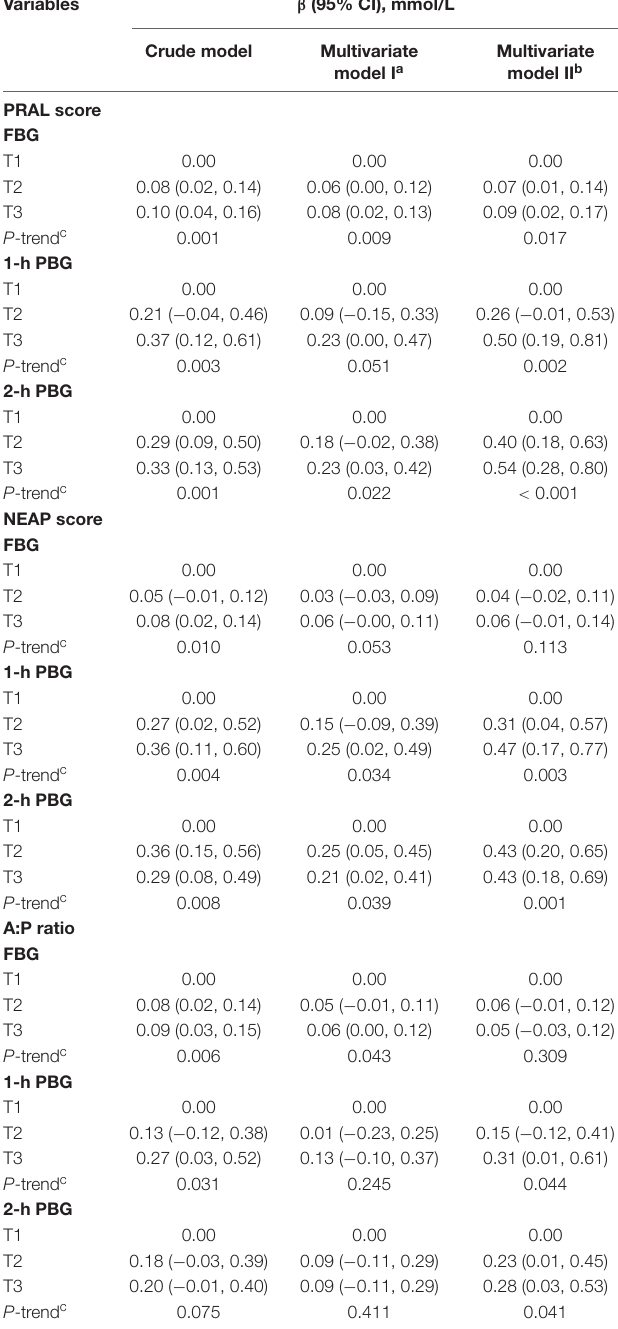
TABLE 4 | Associations between maternal dietary acid load and blood glucose levels. Variables Crude model Multivariate